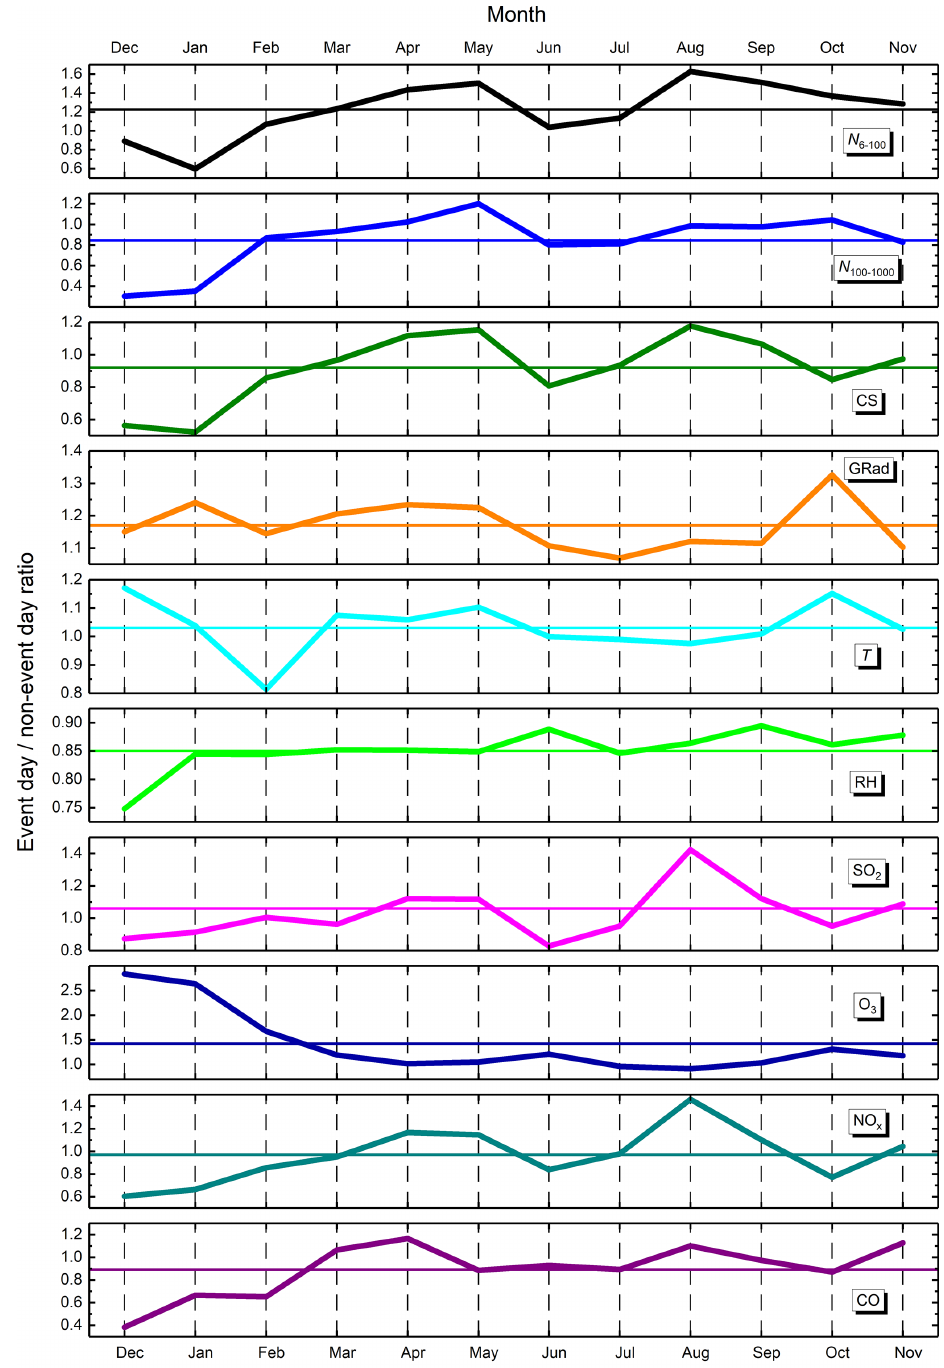
Figure 3. Distributions of ratios for monthly median concentrations of N 6–100 , N 100–1000 , SO 2 , O 3 , NO x and CO, and for monthly mean condensation sink for vapours (CS), global solar radiation (GRad), air temperature ( T ) and relative humidity (RH) on NPF event days to that on non-event days in the city centre for the joint 5-year-long time interval. The horizontal lines represent annual mean ratios.